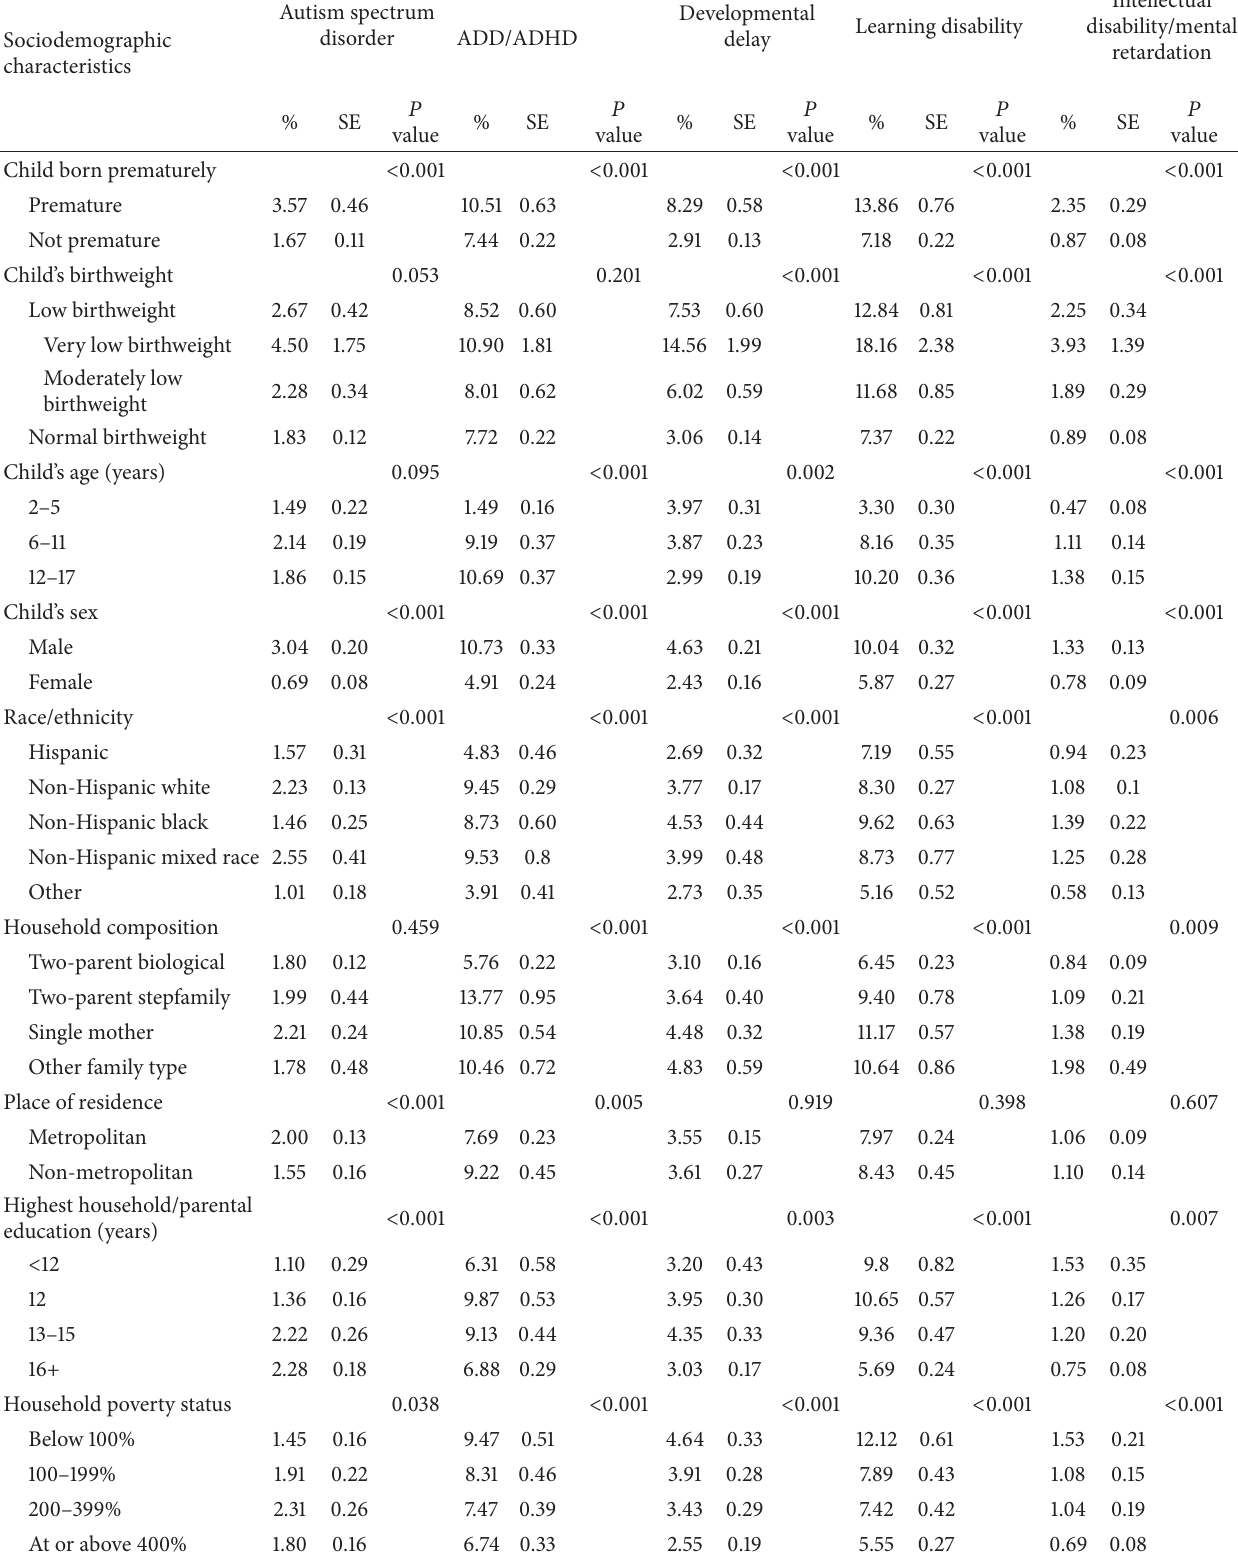
Table 4: Weighted prevalence of selected mental-health-related conditions among US children aged 2–17 years by perinatal and sociodemographic characteristics: the 2011-2012 National Survey of Children’s Health ( 𝑁 =